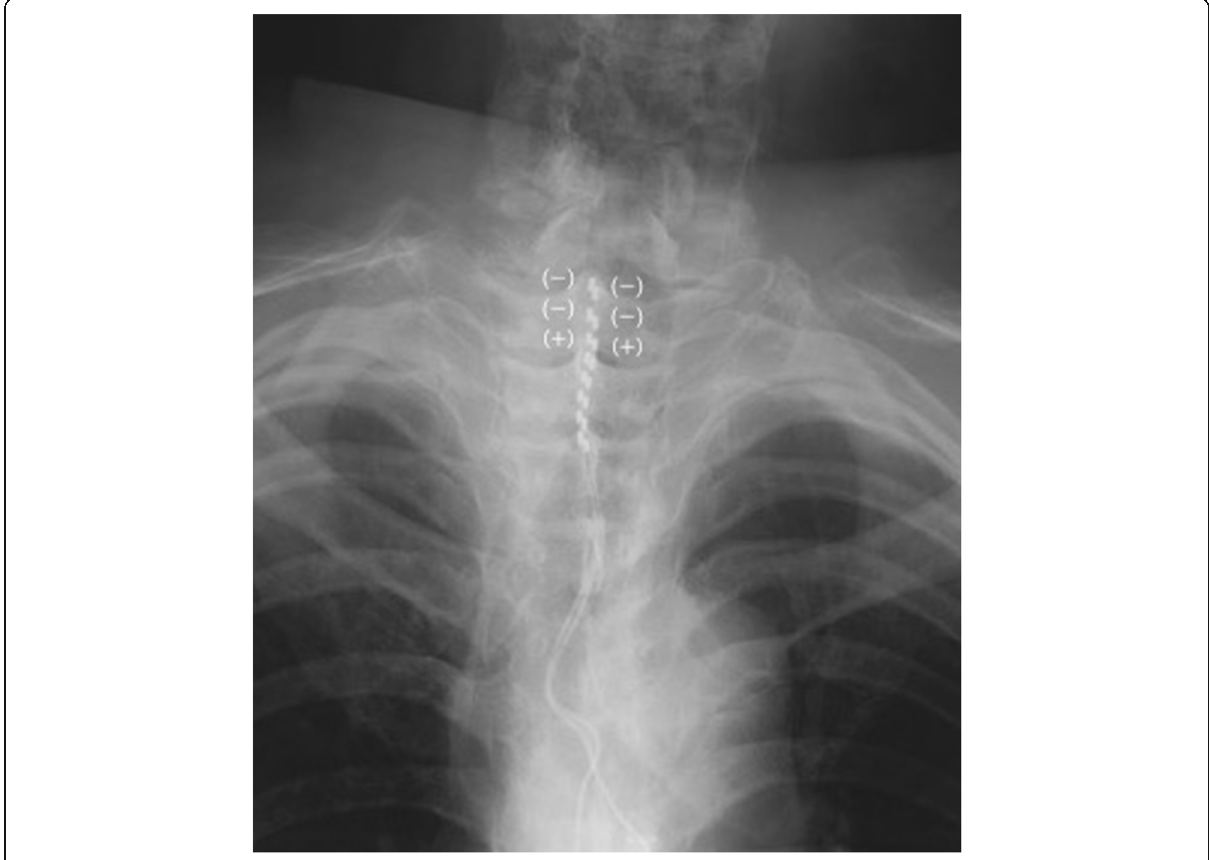
Fig. 2 Fluoroscopy image of the spinal cord stimulator. Two 8-electrode epidural leads in the epidural space were positioned at T1-T3. The electrical stimulations of both leads were applied to the first and second (negative) and third (positive)